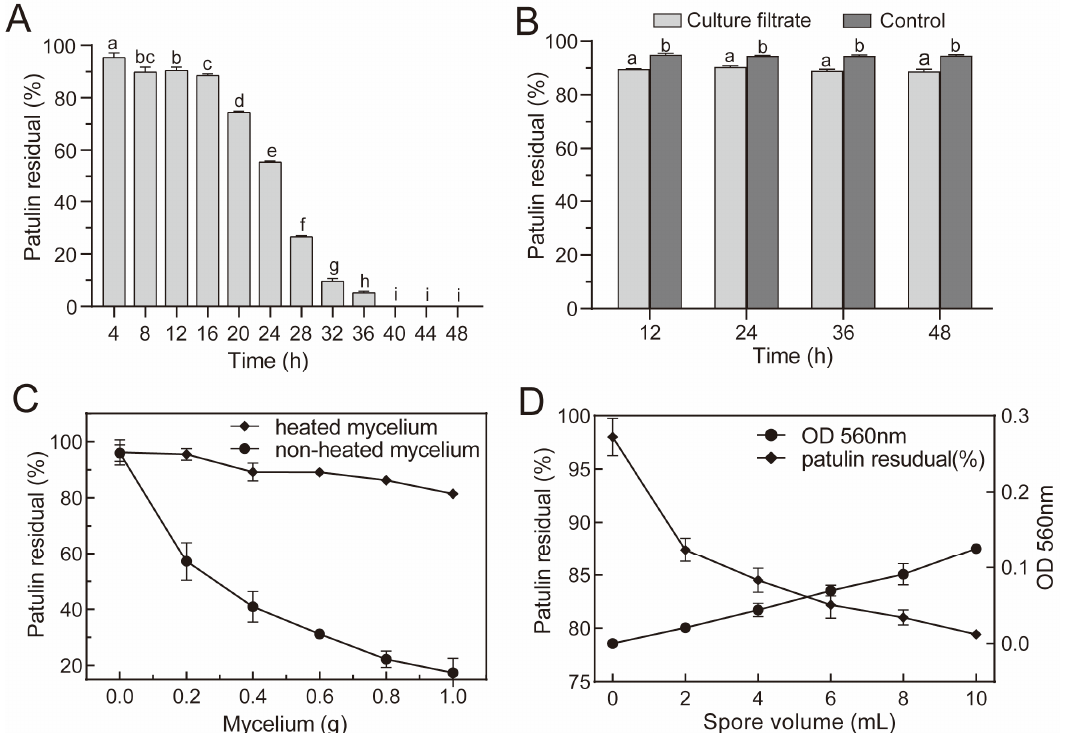
Figure 1. Biodegradation of patulin by A. niger FS10. ( A ) Efficacy of fungal suspension of A. niger FS10 with respect to the degradation of patulin; ( B ) efficacy of culture filtrate of A. niger FS10 with respect to the degradation of patulin; ( C ) Efficacy of mycelia of A. niger FS10 regarding the degradation of patulin; ( D ) efficacy of spores of A. niger FS10 towards the degradation of patulin. Each data bar indicates the means of three replicates ± standard deviation. Different letters indicate a significant difference between them ( p < 0.05).